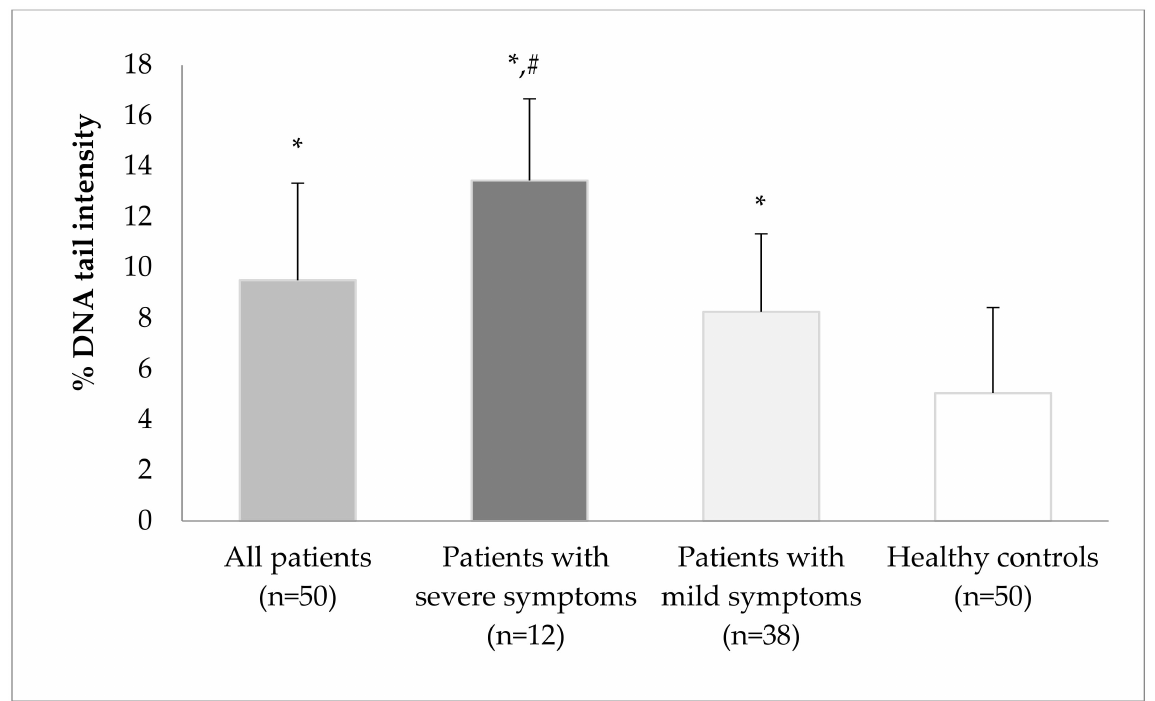
Figure 1. DNA damage in lymphocytes of the study groups using the alkaline comet assay. DNA damage was expressed as DNA tail intensity (% of DNA in the tail) in lymphocytes. The values are given as means ± standard error mean (min–max). * p < 0.05, compared with healthy controls; # p < 0.05, patients with severe symptoms compared with patients with mild